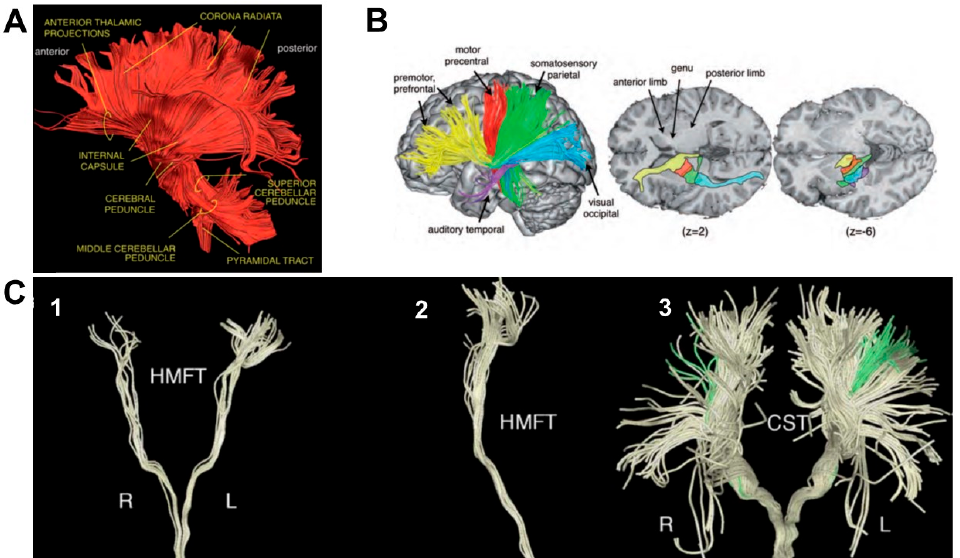
Figure 1. Representative diffusion tensor tractography reconstructions of white matter tracts con- sidered in the study. Panel A: left lateral view of the ascending (sensory) and descending (motor) projection pathways forming the corona radiata. Panel B: motor and thalamic pathways distribution along the internal capsule. The colored tracts indicate the anterior (yellow), superior (red and green), posterior (blue), and inferior (purple) thalamic peduncles; z values indicate the number of the slice on the z-plane. Panel C: hand related motor fiber tracts (HMFTs). (1) front view in the coronal plane and (2) viewed from the right side; (3) front view of the CorticoSpinal Tract (CST– light yellow) and the HMFTs (green) as a subset of CST fibers. R= right; L= left. Panel A and B: adapted from Catani, M. 2012; Panel C: adapted from Dalamagkas, K.; 2020.